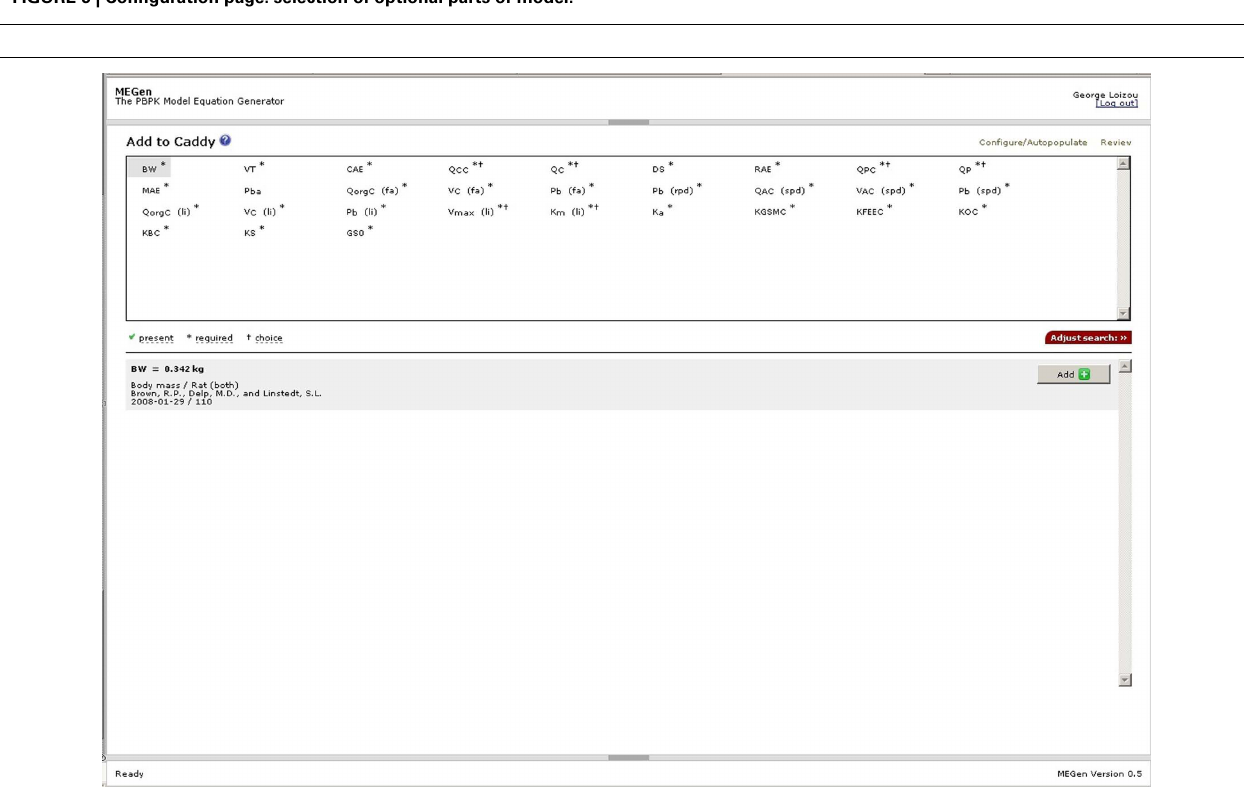
FIGURE 6 | Configuration page: selection of optional parts of model.